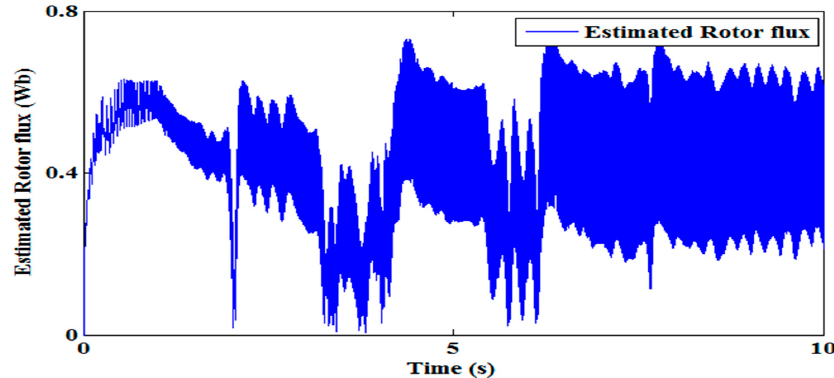
Figure 13. Estimated rotor flux of SMLO 2.